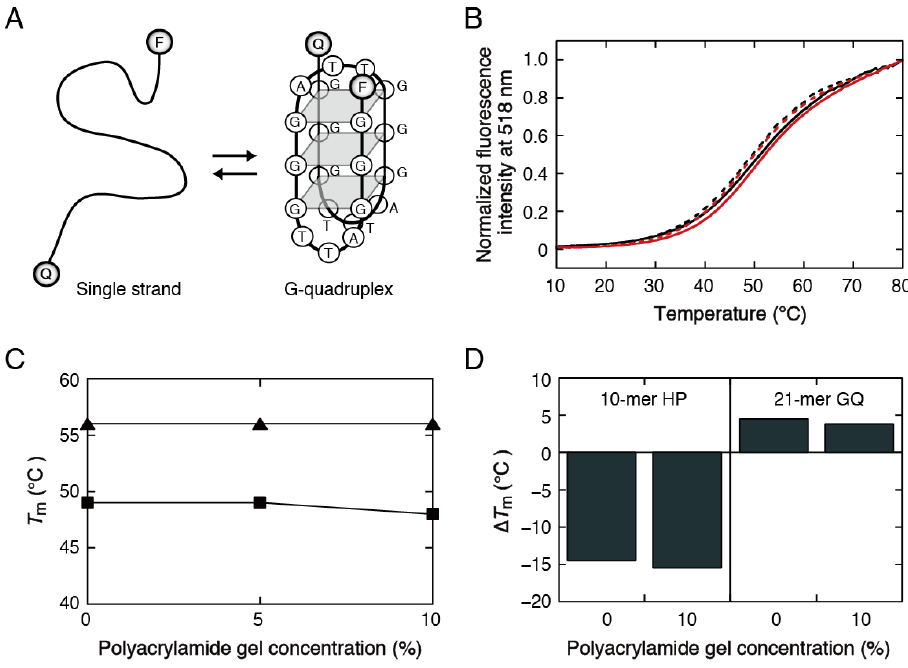
Figure 4. ( A ) Equilibrium for the G-quadruplex formation of 21-mer GQ by a single strand bearing a fluorophore, F, and a quencher, Q. ( B ) Melting and annealing curves (solid and dotted lines, respectively) of 21-mer GQ in the 10% polyacrylamide gel (red) and the solution (black). ( C ) The T m values of 10-mer HP (triangles) and 21-mer GQ (squares) in the solution (represented as 0%) and the polyacrylamide gels at various concentrations. ( D ) Changes in the T m values of 10-mer HP and 21-mer GQ by the addition of PEG with an average molecular weight of 200 to the solution (represented as 0%) and the polyacrylamide gel at